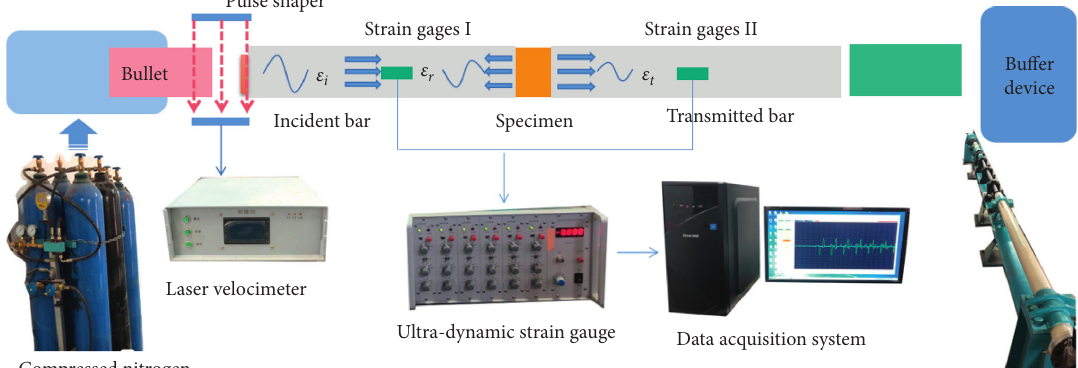
Figure 1: SHPB testing system.